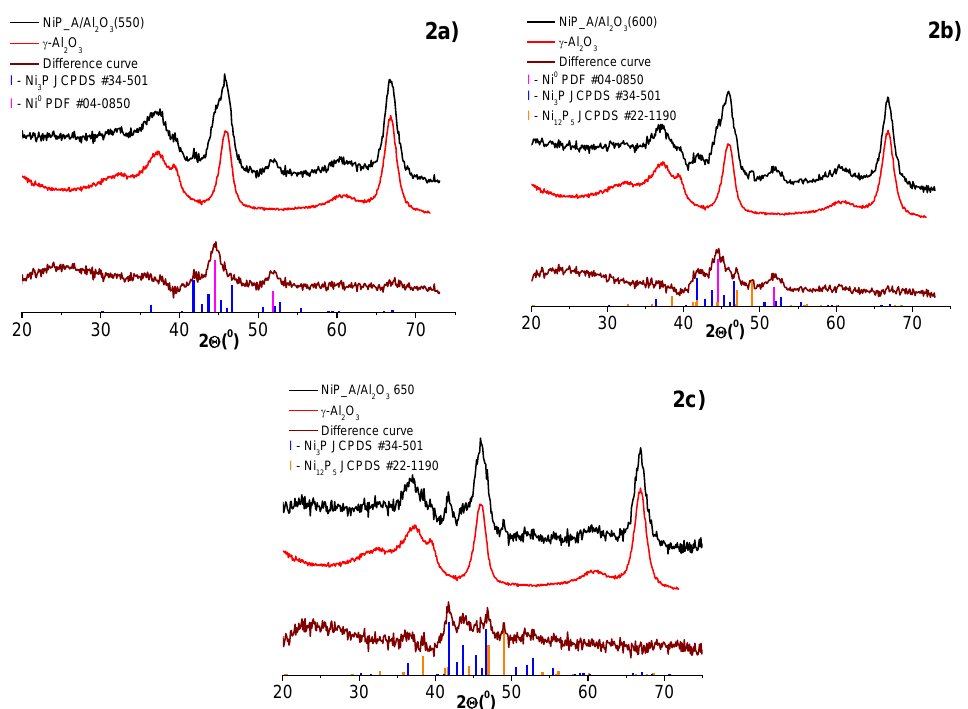
Figure 2. XRD patterns of NiP_A/Al 2 O 3 catalyst prepared from phosphate precursor and reduced at temperature of 550 °С ( a ), 600 °С ( b ) or 650 °С ( c ), γ-Al 2 O 3 support and the difference curve.